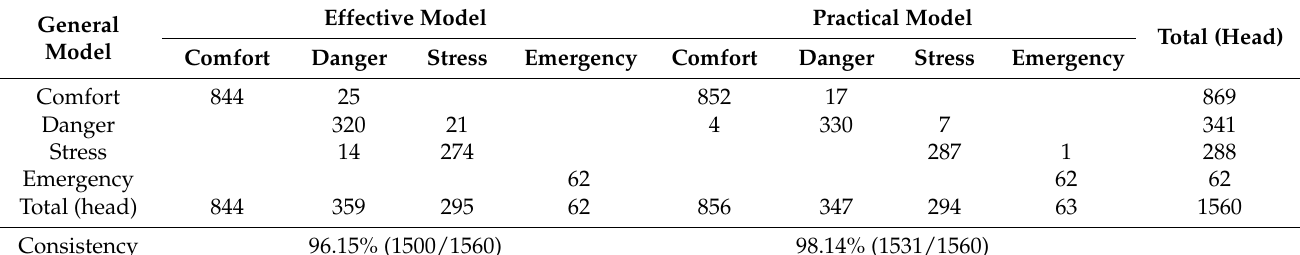
Table 7. Relationship among the classification of different thermal comfort models.